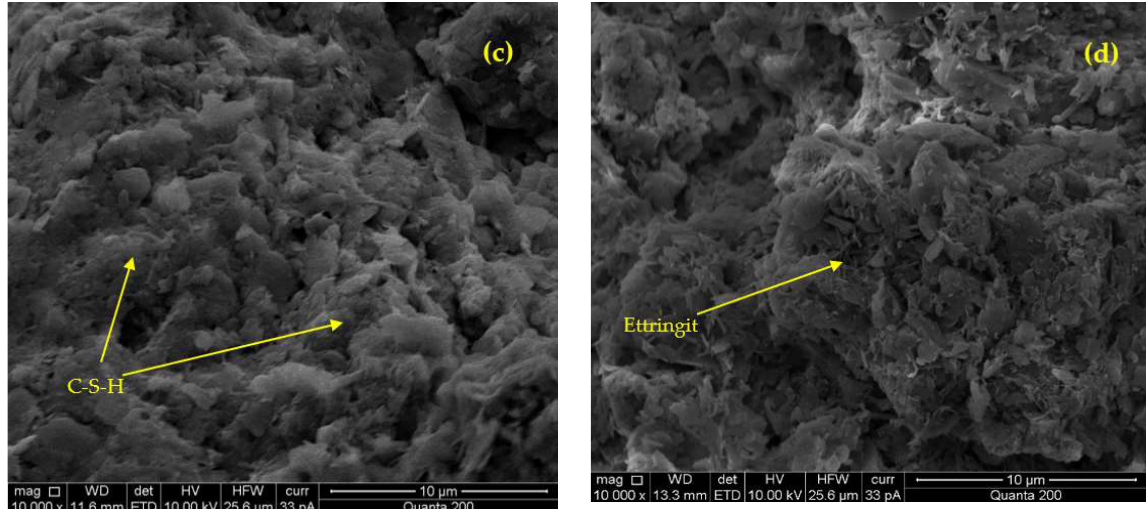
Figure 9. SEM of ( a ) soil treated with 6% GGBS (6G) at 7 days, ( b ) soil treated with 6% GGBS (6G) at 28 days, ( c ) soil treated with 6% CKD (6C) at 7 days, ( d ) soil treated with 6% CKD (6C) at 28 days.